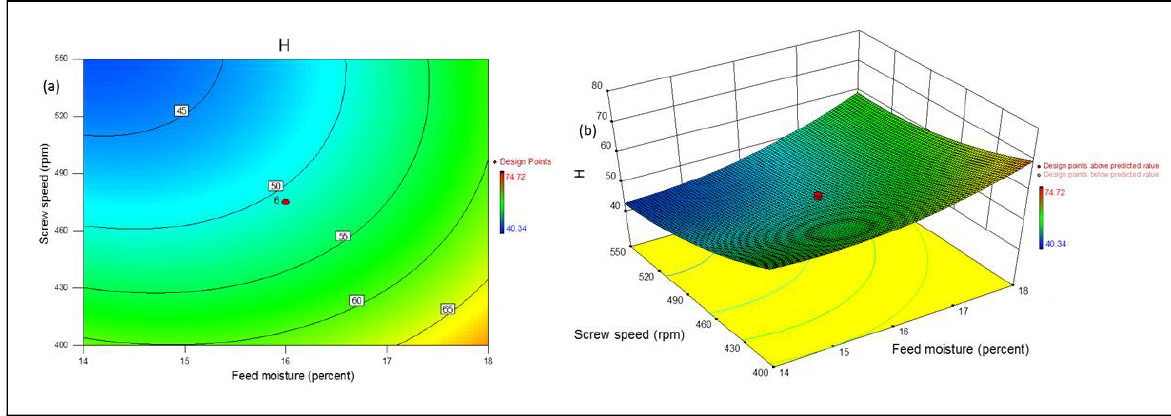
Figure 6: Contour (a) and Response surface (b) plot depicting the behavior of hardness at different feed moisture and screw speed while the other processing variables are at center